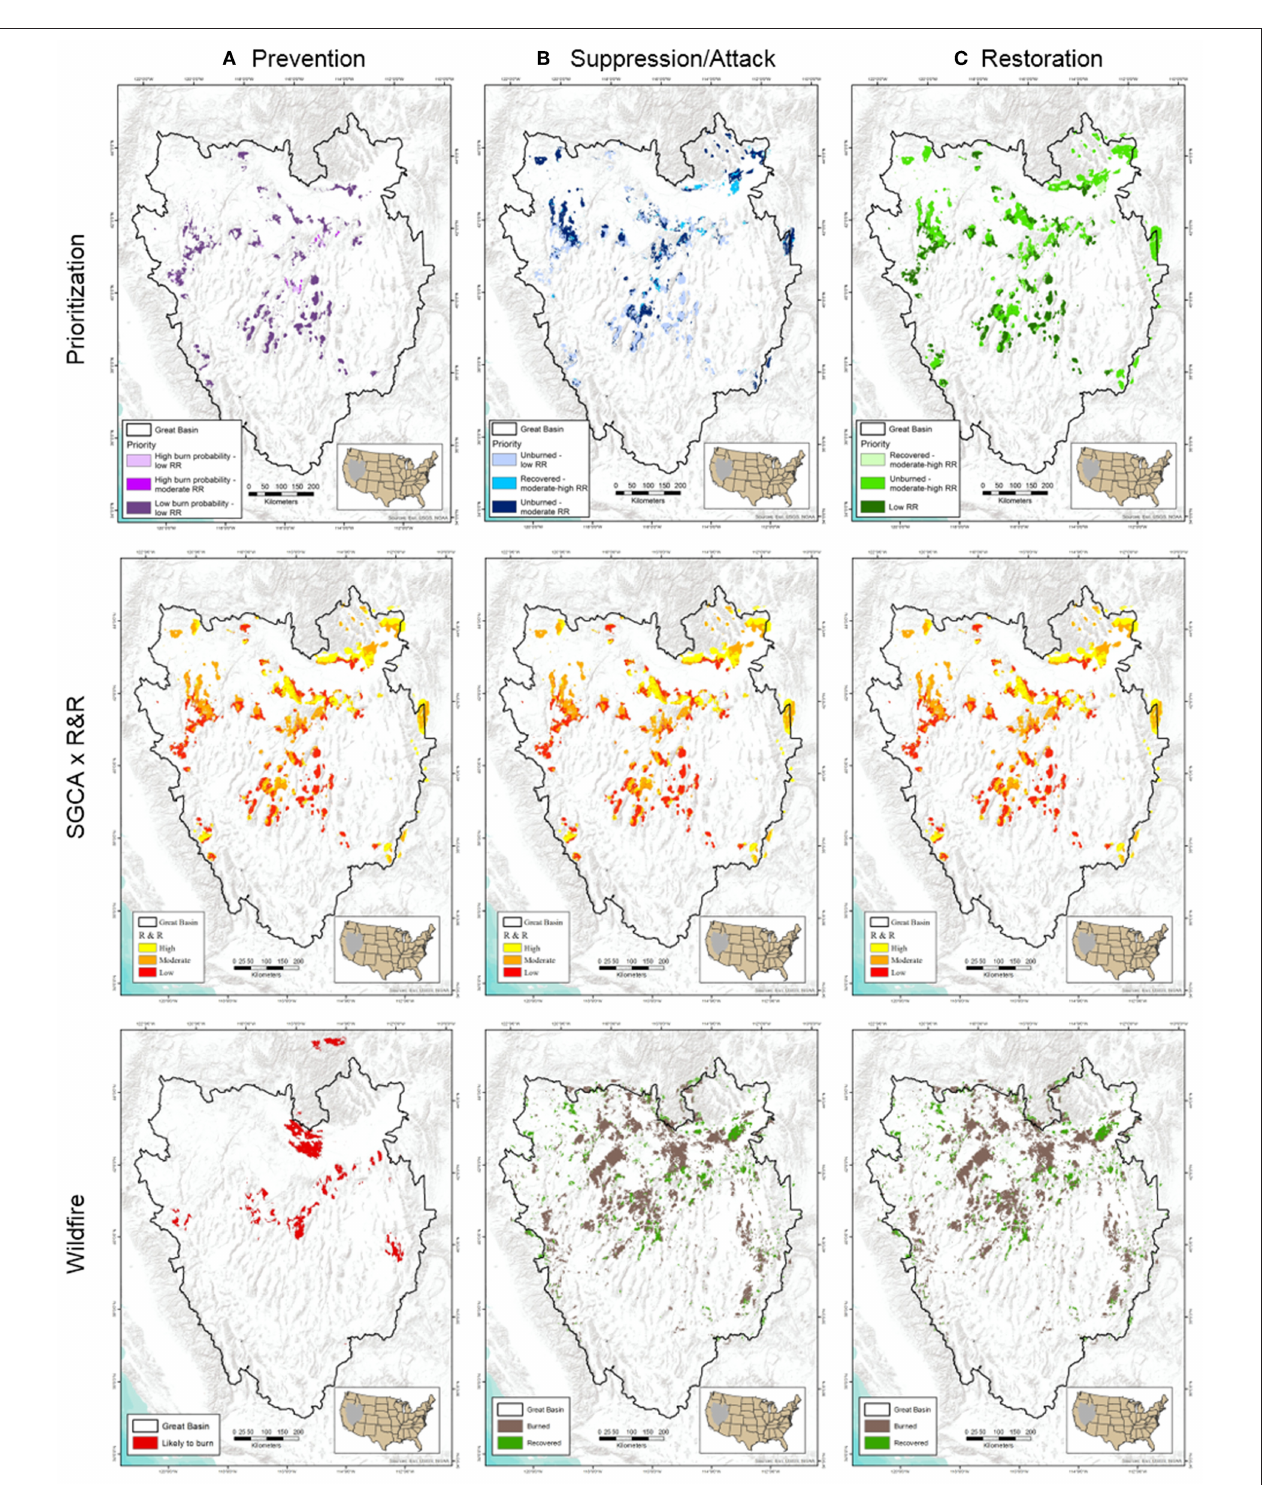
FIGURE 3 | Example spatially explicit strategies for prioritizing wildfire management in the Great Basin based on geospatial intersections of fire probability (Short et al., 2016), wildfire impacted areas (Coates et al., 2016a), soil regime-based resilience and resistance indices (RandR, Maestas et al., 2016), and sage-grouse concentration areas (SGCA, Coates et al., 2016a). The top row represents example prioritization for wildfire prevention (A) , suppression and initial attack (B) , and restoration (C) given results of spatial intersections (lower row) for fire probability (left column) or cumulative (or recovered) burn area (middle and right column), and SGCA x RandR (middle row). Prioritizations are ranked in descending